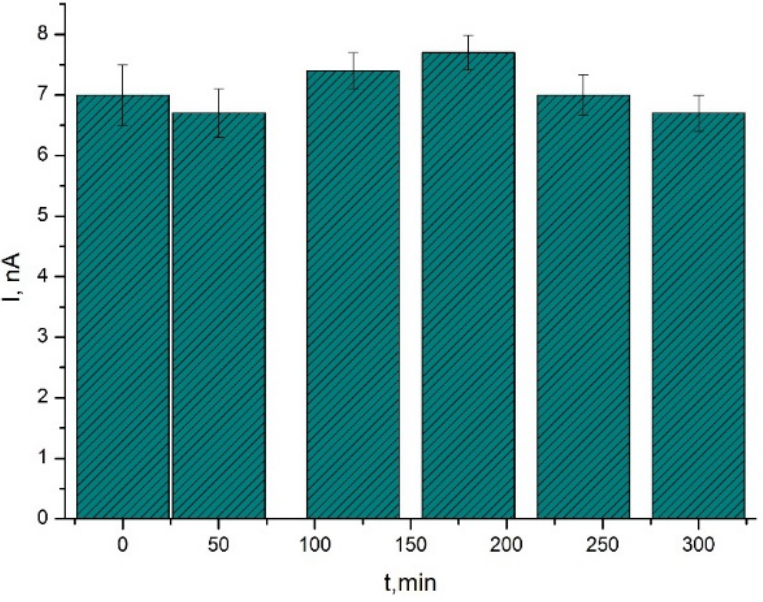
Figure 7. Reproducibility and operational stability of the biosensor. D-Tagatose (11.0 mM) in a stirred PBS, pH 7.5. PBS, pH